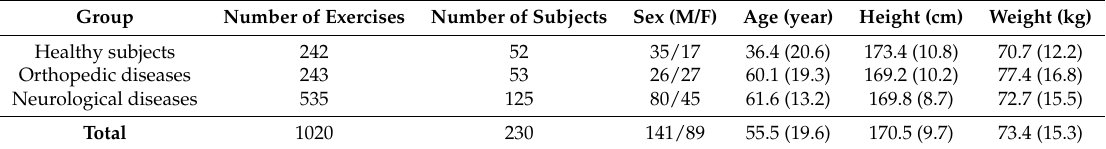
Table 1. Subjects’ characteristics. For the age, height and weight, the mean and the standard deviations are displayed.